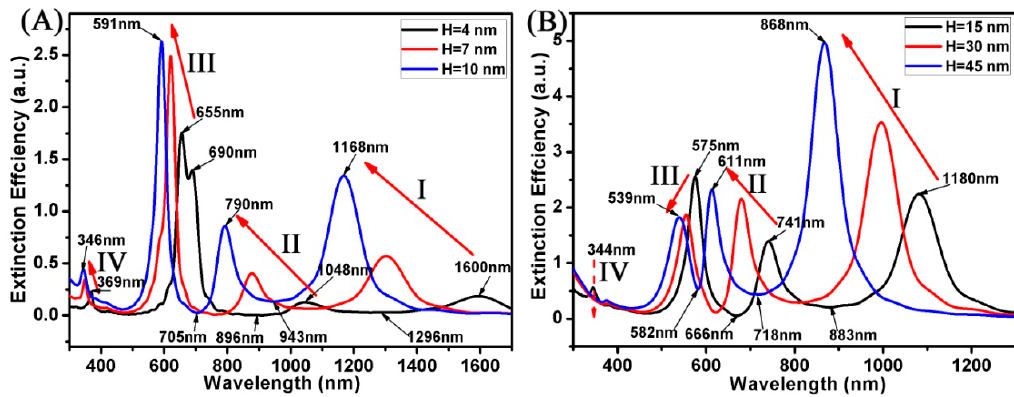
Figure 7. ( A , B ) Spectra calculated for the Au ring-disk nanostructures with different H. The R 1 and the R 2 of the Au ring was unchanged (R 1 = 20 nm; R 2 = 30 nm). The R 3 of the disk was 30 nm. The H increased from 4 to 45 nm.